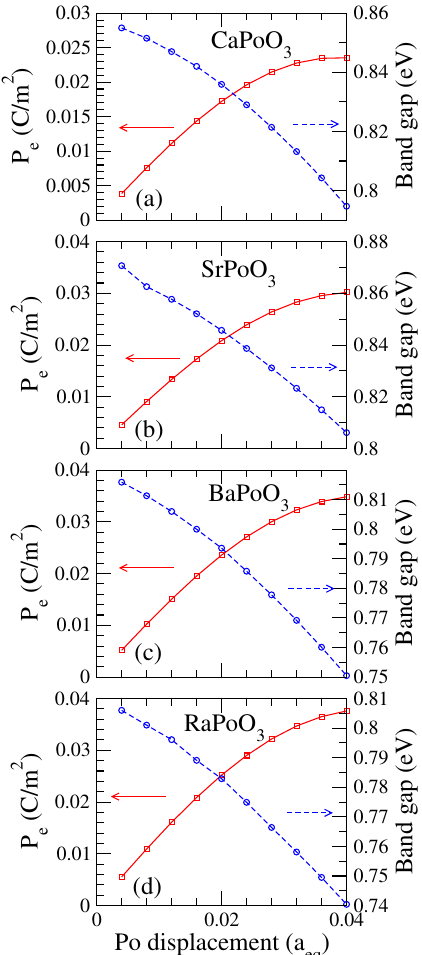
Figure 5. Calculated electric polarization P e , in C/m 2 , and fully relativistic bandgap, in eV, for the ( a ) CaPoO 3 , ( b ) SrPoO 3 , ( c ) BaPoO 3 and ( d ) RaPoO 3 as a function of the lattice constant with respect to its equilibrium lattice constant a eq